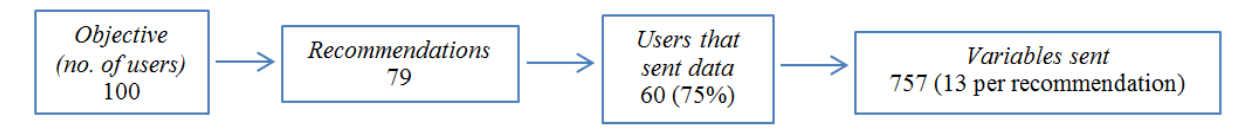
Figure 2. Participant attrition diagram.